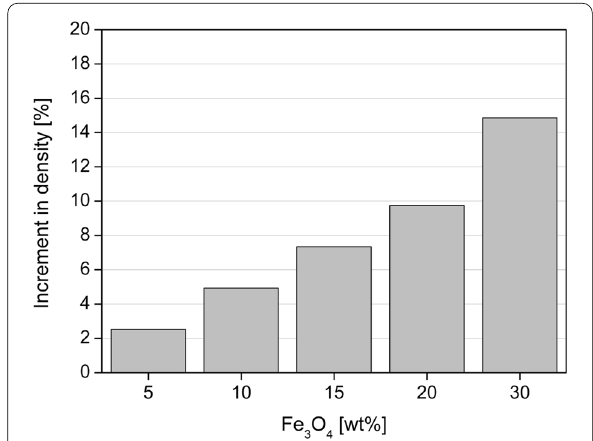
Fig. 3 Percentage density increment in specimens containing nano‑Fe 3 O 4 , in comparison with pristine (NM0) cement